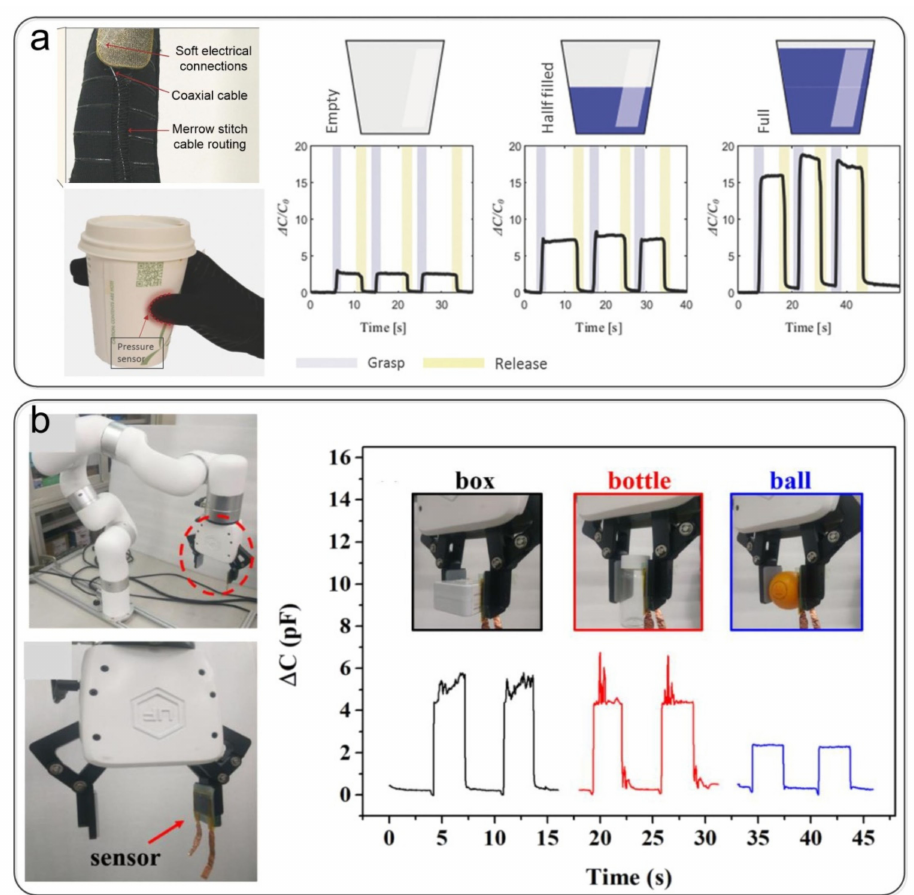
Figure 11. Pressure sensors are used in robotic sensing. ( a ) Textile gloves for grip detection. Repro- duced with permission from Ref. [100]. Copyright 2017 Wiley-VCH. ( b ) Real-time monitoring of a robotic arm grasping objects. Reproduced with permission from Ref. [96]. Copyright 2021